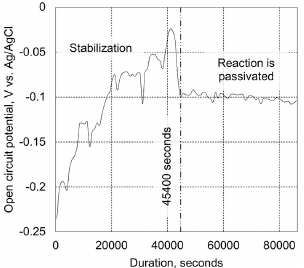
Figure 5. Chronopotentiometry result to show evolution of open circuit potential (vs. Ag/AgCl) of AlCrN PVD coated AISI 316L sample in the 3.5 wt % NaCl solution (static test duration–86,400 s/24 h).